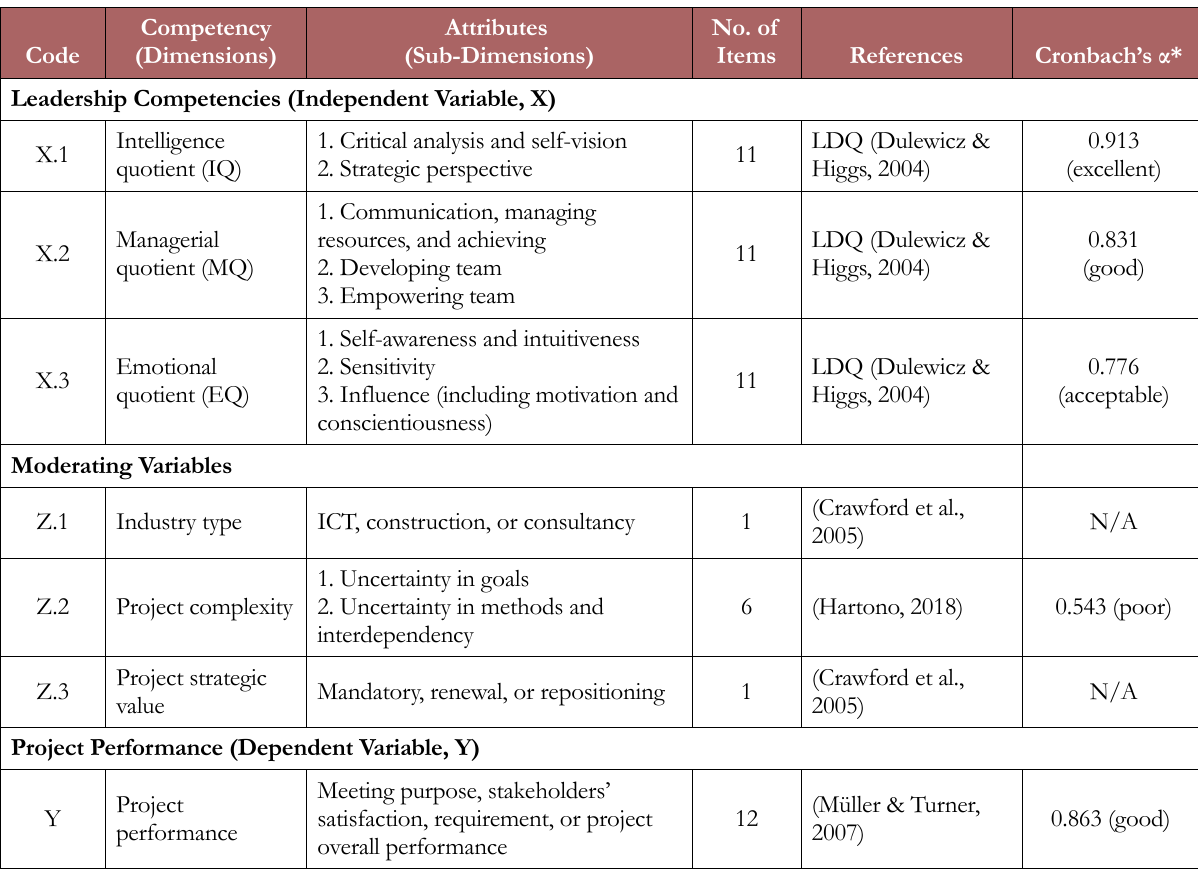
Table 1. Key Variables and Dimensions (Final